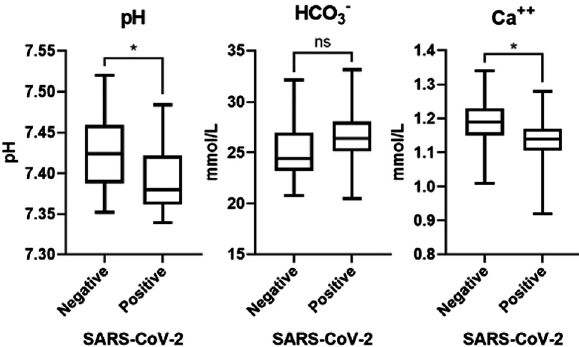
Figure 2: Graphs depicting mean and range of pH, bicarbonate concentration (HCO 3 − ) and ionized calcium concentration (Ca ++ ) data of patientstestednegative andthose testedpositivefor SARS-CoV-2. *p ≤ 0.05, ns-not statistically signi fi cant. All patients received a routine venous blood gas analysis upon admission using ABL 800 FLEX blood gas analyzer (Radiometer, Germany). The only exclusion criteria was previous SARS-CoV-2-positivity prior to admission.